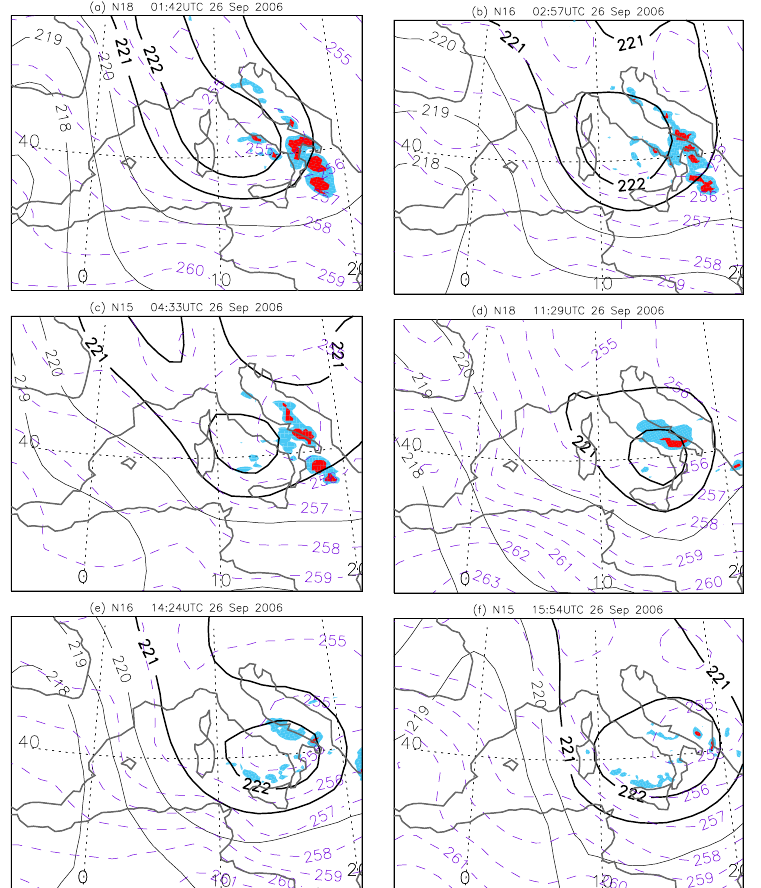
Fig. 7. AMSU-A channel 8 (solid, thick dark for A-8 BT larger or equal to 221K), AMSU-A channel 5 (dashed, purple), B3m5 (larger or Figure 7 Figure 7 equal to − 8K, blue shaded), and DCT (red shaded), for: (a) NOAA-18, 01:42UTC, (b) NOAA-16, 02:57UTC, (c) NOAA-15, 04:33UTC,